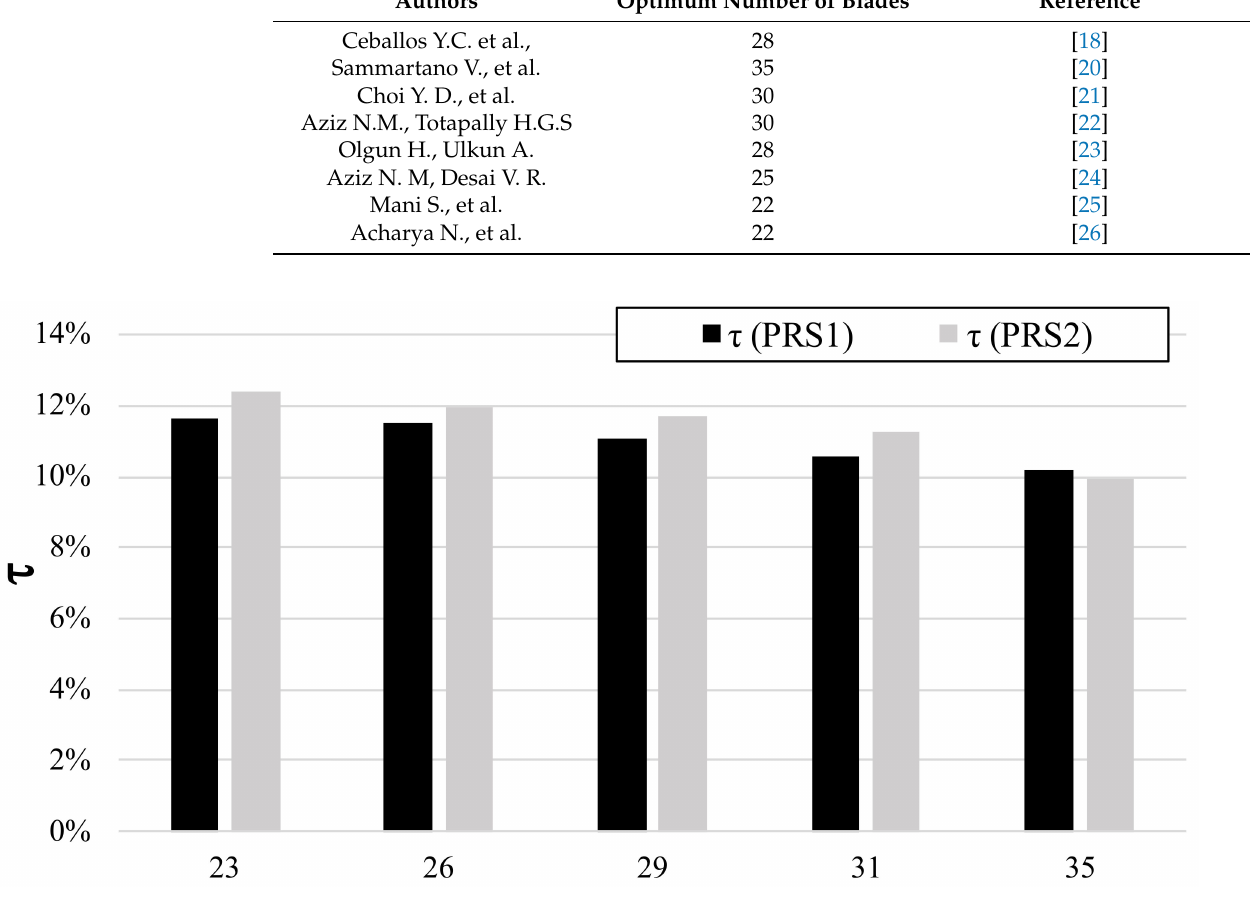
Figure 10. Maximum torque ratio τ versus number of